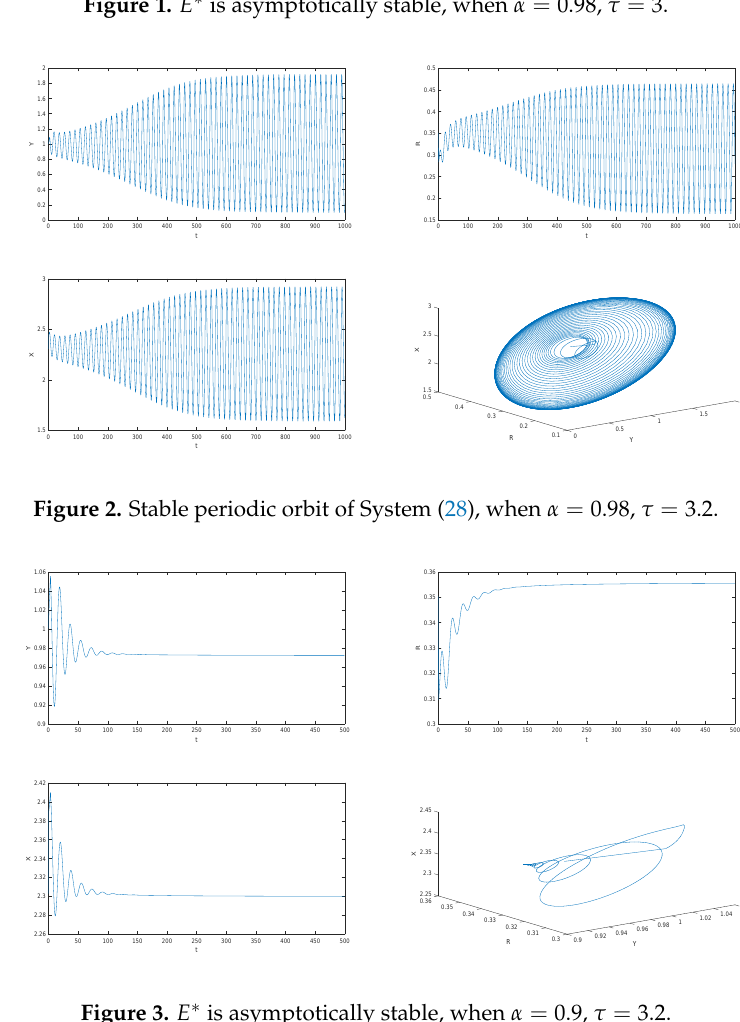
Figure 3. E ∗ is asymptotically stable, when α = 0.9, τ =